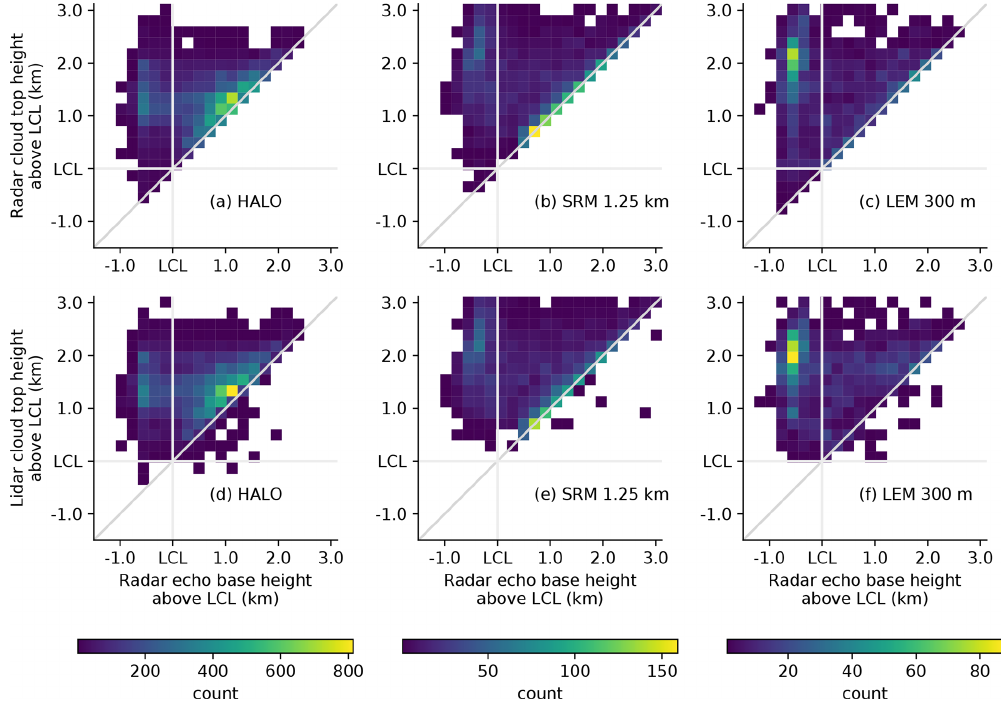
Figure 6. Relation of radar-detectable cloud top height (a–c) and lidar-detectable cloud top height (d–f) above LCL vs. radar echo base height above LCL. Based on HALO observations (a, d) , the 1.25km SRM dataset (b, e) , and the 300m LEM dataset (c, f)